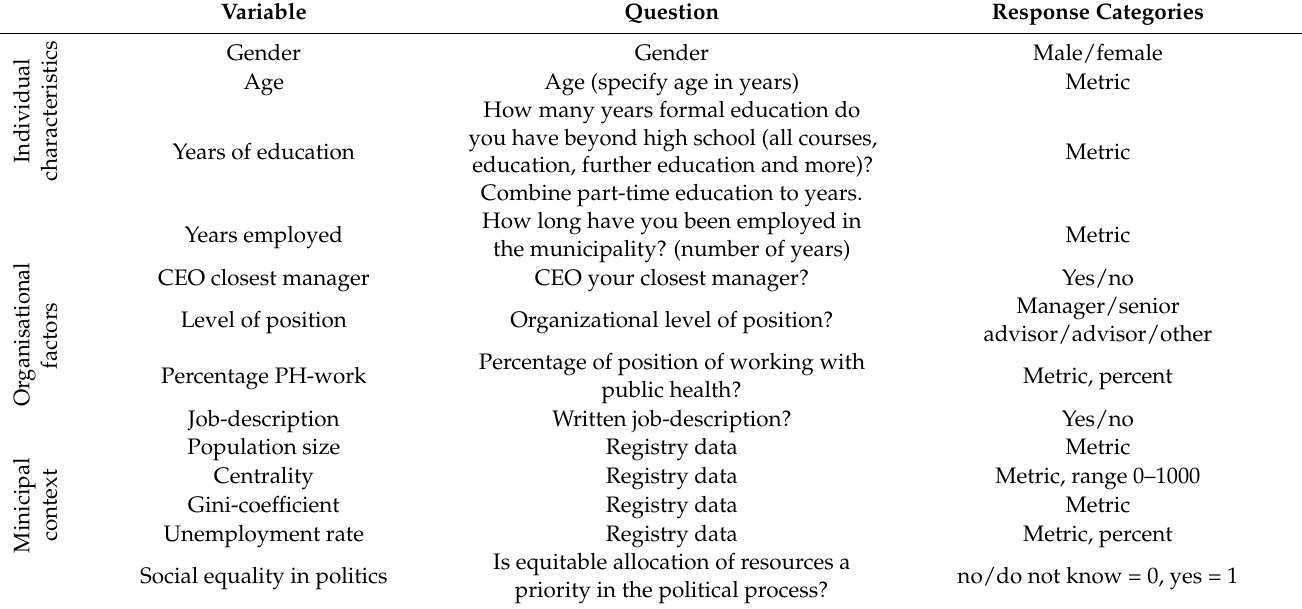
Table 1. Included variables and response